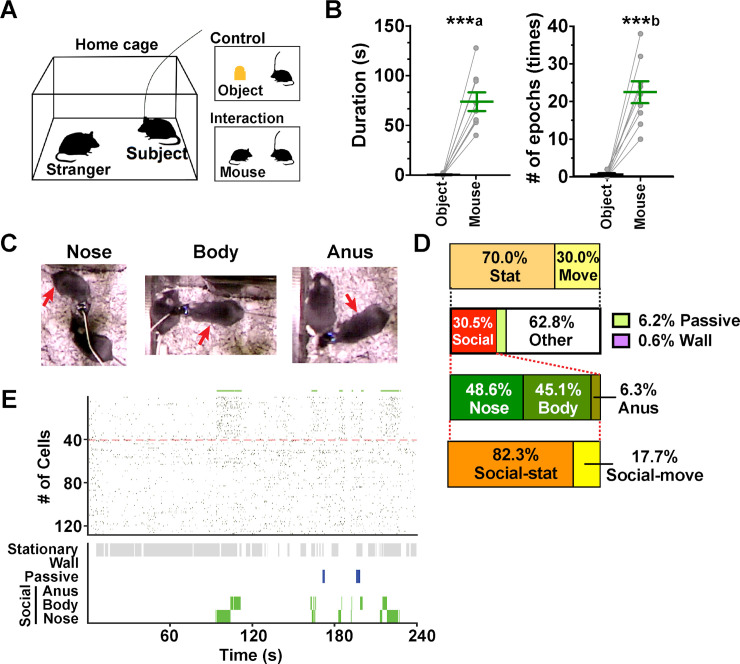
Behavior during HC experiments.(A) Experimental design of HC experiment. A subject mouse was allowed to explore a novel object in its HC for 4 min in a control session (top right), followed by an additional 4 min of an interaction session with a stranger mouse (bottom right). (B) Total duration (left) and the number of nasal contact epochs (right) with a novel object during control sessions and with a stranger mouse during interaction sessions. ***a, P < 0.0001 versus object, t(8) = 7.90, paired t test. ***b, P < 0.0001 versus object, t(8) = 7.35, paired t test, n = 9 mice (S1 Data, sheet Fig 1B). (C) Sample video frames of contact with the nose, body, and anus of the stranger. The subject mouse (red arrow) has a miniaturized microscope attached to its head. (D) Characterization of the behavior of subject mice in HC experiments. The fractions of time spent moving (“Move”) and not moving (“Stat”) and those for social interaction (“Social”), passive touch by the stranger (“Passive”), contact with the wall (“Wall”), and otherwise (“Other”) in entire sessions are shown in the top and upper middle bars, respectively. The bars presented in the lower middle and bottom indicate the fractions of time spent touching the nose, body, and anogenital areas (“Anus”) and those spent moving (“Social-move”) and not moving (“Social-stat”) during the periods of social interaction, respectively. (E) Behavior of a subject mouse during a single HC experiment (bottom). Nonmoving periods (“Stationary”), contact with the wall (“Wall”), passive touch by the stranger mouse (“Passive”), and contact with the anogenital area (“Anus”), body, and nose of the stranger are presented from top to bottom within the panel. The top panel presents a raster plot showing Ca2+ events of a population of AI neurons imaged during the same experiment (n = 128 neurons; see Fig 2A–2C for technical details). The epochs of social interaction are indicated by green horizontal bars shown on the top. Social-ON cells are sorted above the red dashed line. AI, agranular insular cortex; HC, home cage.